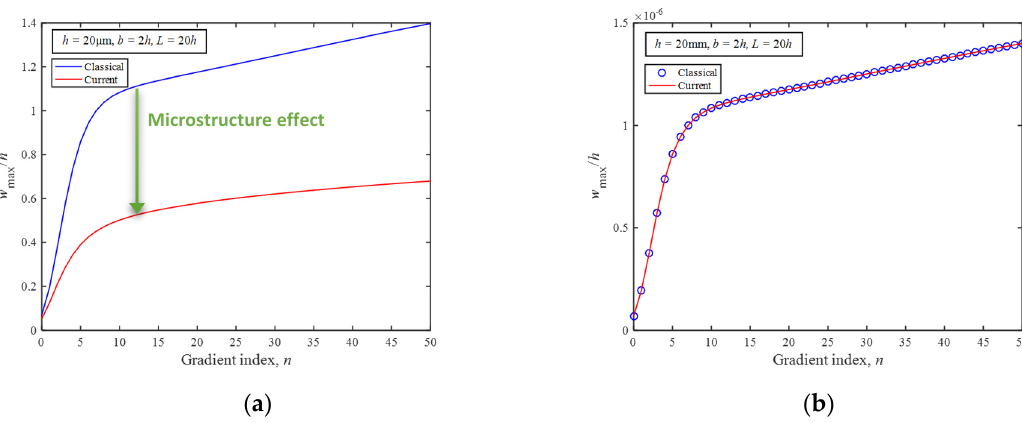
Figure 9. Maximum deflections of the MEE-FGM beam for different gradient index with ( a ) h = 20 µ m, ( b ) h = 20 mm.